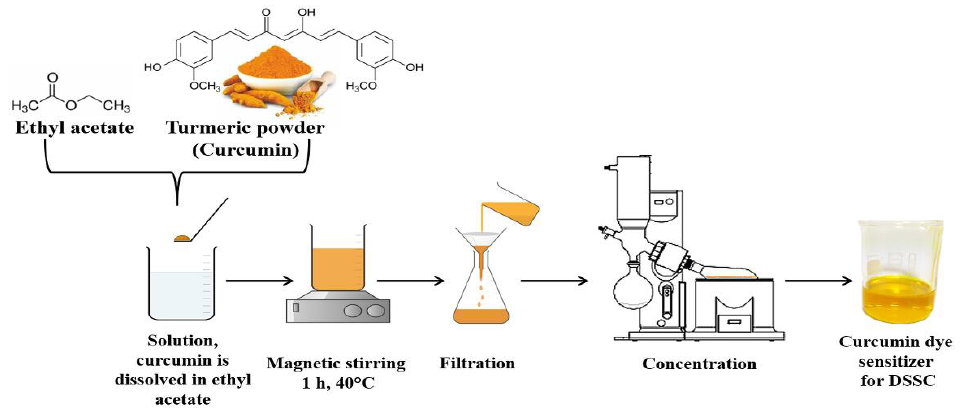
Figure 1. The Curcumin dye extraction